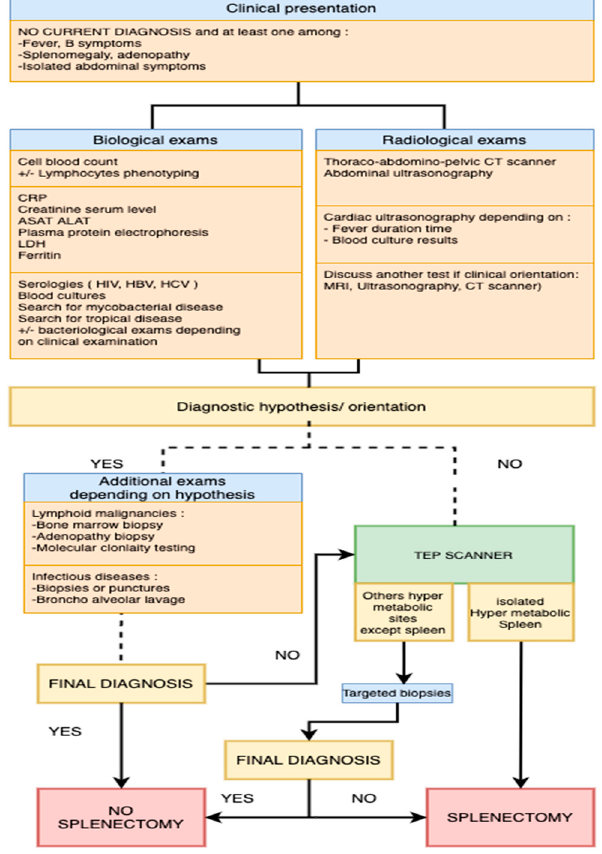
Figure 3. Diagnostic splenectomy: an algorithm to help clinical decision-making according to first-line examinations.